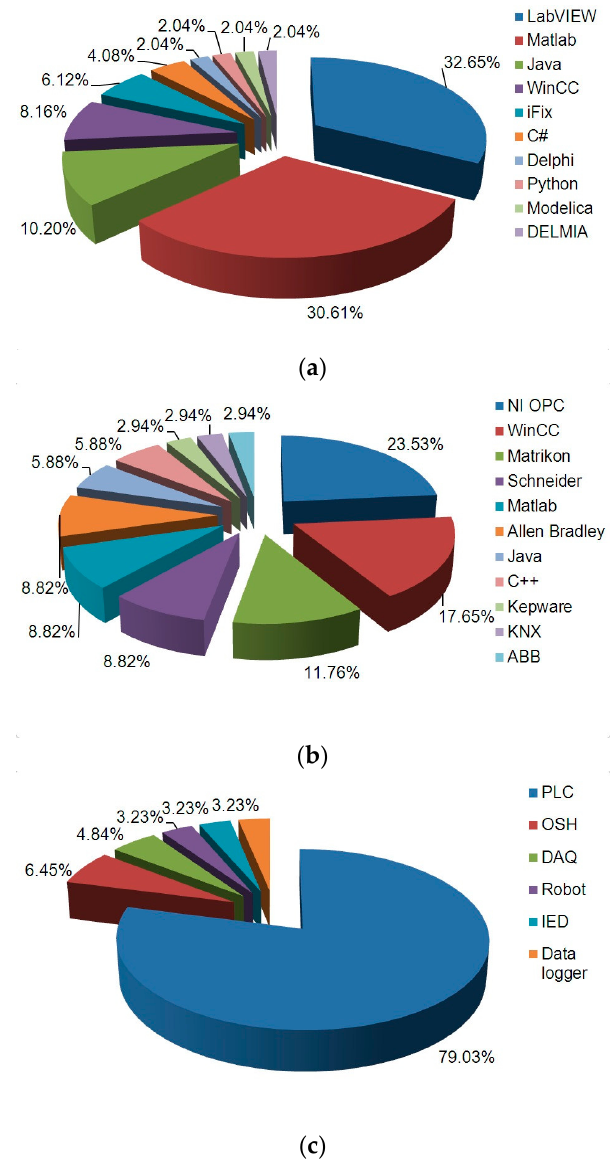
Figure 12. Overview of the software and hardware entities used by the reviewed works: ( a ) OPC client software; ( b ) OPC server software; ( c ) Hardware devices.